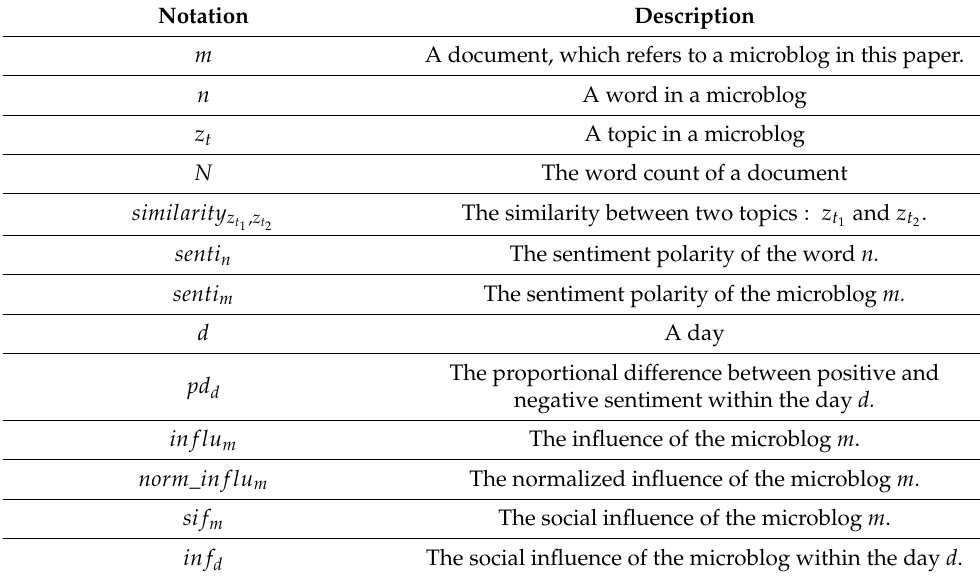
Table 1. Notations used in our